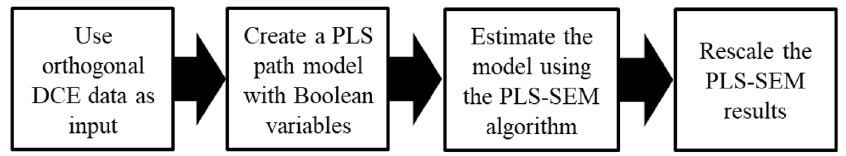
Fig. 3 DCE data use in